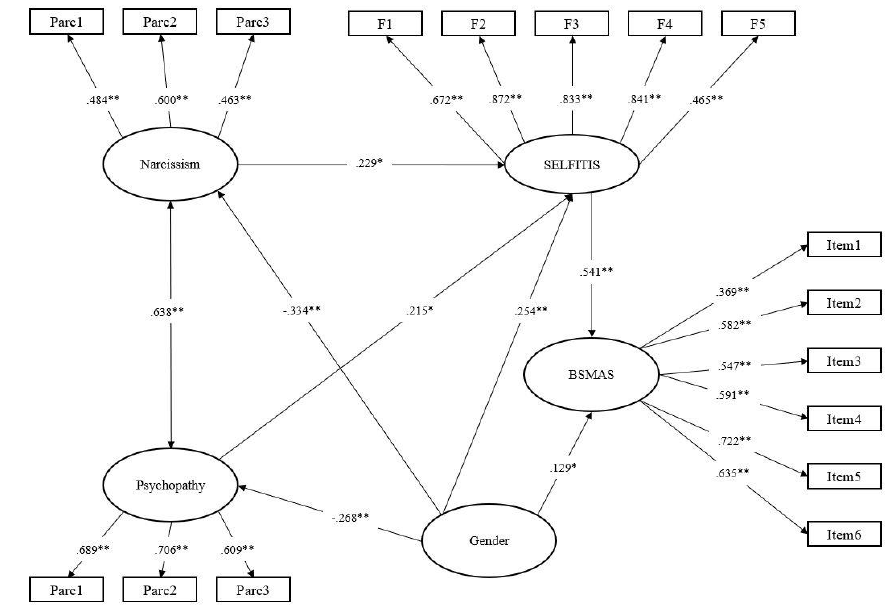
Figure 1. Selfitis as mediator in the relationships between narcissism, psychopathy, and social media addiction. Note. Full standardized coefficients are reported; * p < 0.05. ** p < 0.001.